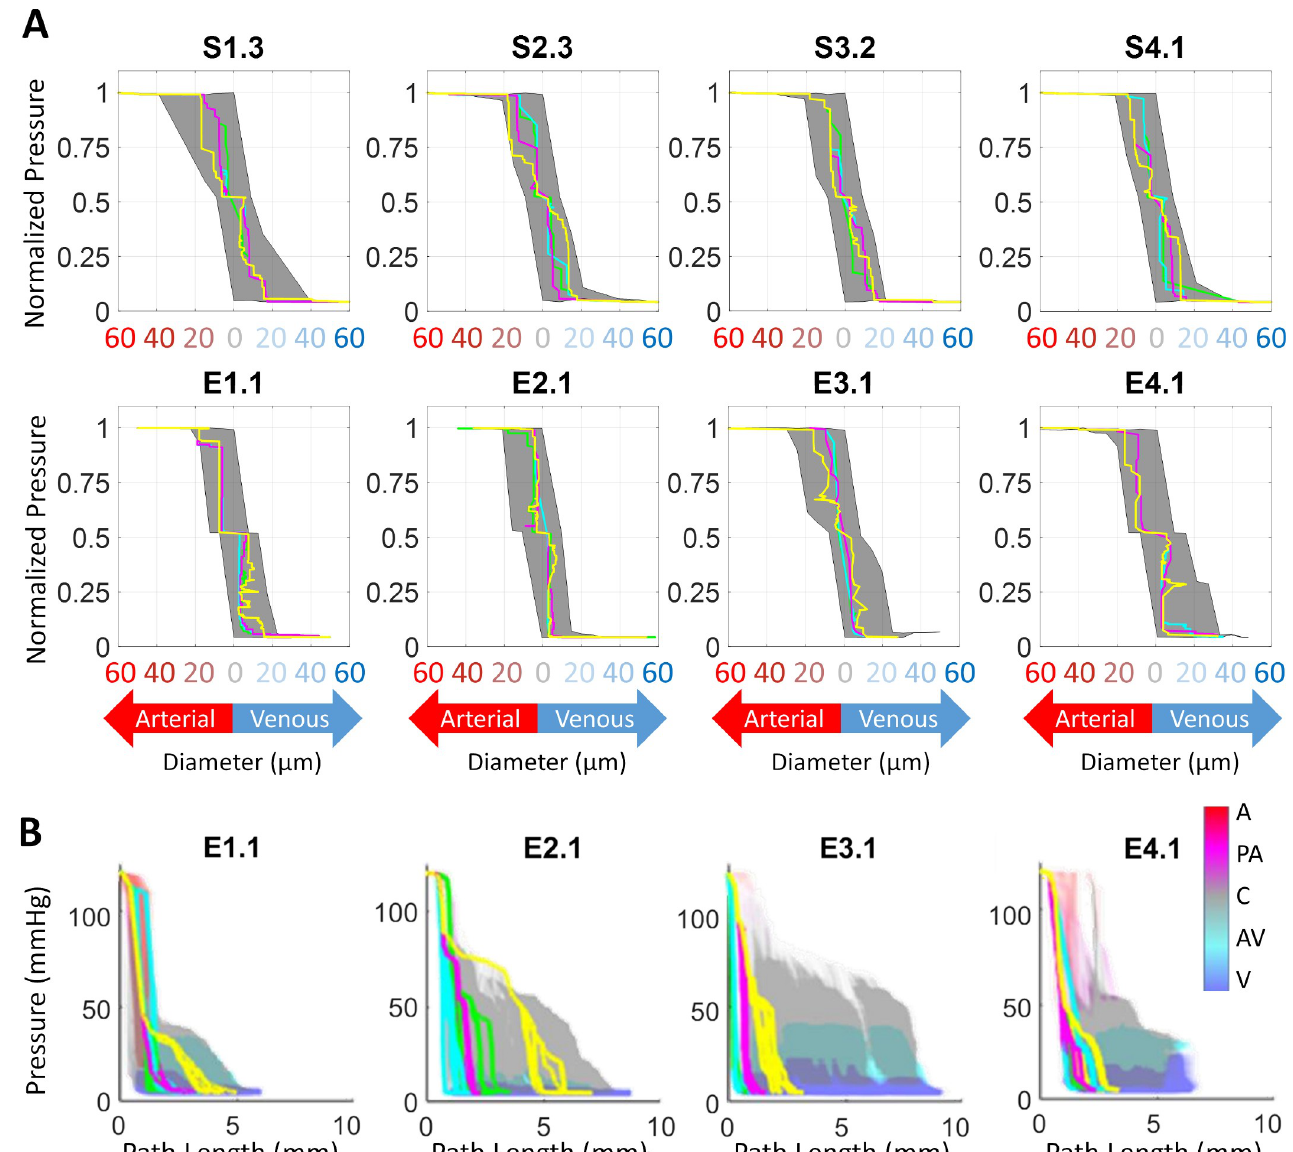
Fig 2. Predictions of hemodynamic states in primary cortex simulations show large variations due to network architecture. (A) Path analysis (N = 2,300– 22,052 paths per dataset) of blood pressure as a function of diameter. (It should be noted that some paths in the experimental data sets e.g. E1.1 exhibit zigzagging which is probably due to uncertainty in the diameter information). (B) Blood pressure as a function of path length in four microcirculatory data sets. Representative path trajectories have been plotted in green, blue, magenta and yellow (A-arteries, PA-penetrating arteries, C-capillaries, AV-ascending venules,